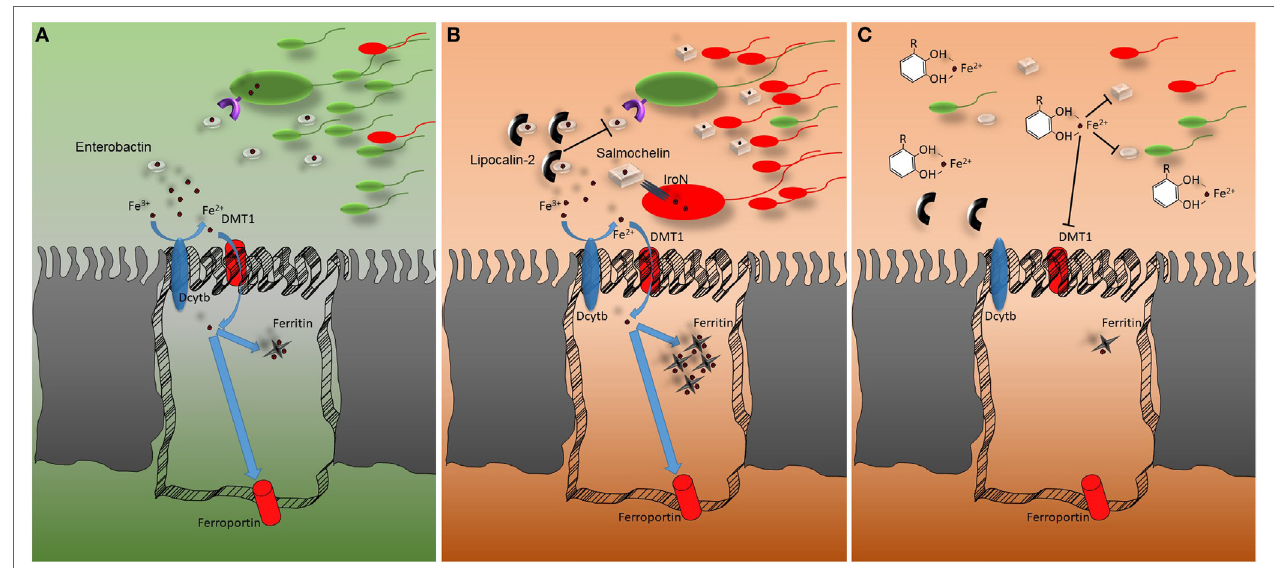
FiGUre 1 | Representation of the host–microbiota battle for iron. (A) In homeostatic conditions, Fe 3 + is reduced to Fe 2 + by the ferrireductase (DcytB) activity before being imported through the epithelial divalent metal transporter DMT1. Once inside the cells, iron can be accumulated, bound by ferritin, or exported via ferroportin. The gut microbiota relies on low-molecular-weight iron chelators (siderophores) for receptor-mediated iron uptake. The most common siderophore is enterobactin. (B) In conditions of intestinal inflammation lipocalin-2 secretion from epithelial and myeloid cells is upregulated. Lipocalin-2 reduces iron availability for gut microbiota by binding enterobactin and thus impairing enterobactin-mediated iron acquisition. Pathogens that do not strictly rely on enterobactin for iron uptake gain an advantage from lipocalin-2 mediated commensal growth, which hampers secreting glucosylated variants of enterobactin which are not bound by lipocalin-2. (c) Polyphenols can bind iron with strong affinity. DMT1 fails to transport the polyphenol–iron complex into epithelial cells. Most likely, the polyphenol–iron complex reduces iron availability in the intestinal lumen, impairing gut microbiota growth. This aspect should be taken into account during intestinal inflammatory events associated with microbial